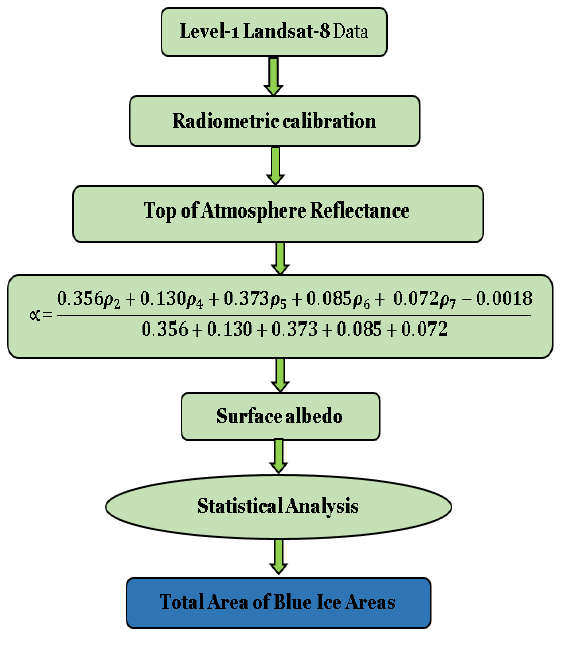
Figure 3: Protocol for deriving blue ice areas from Landsat-8 by computing albedo.